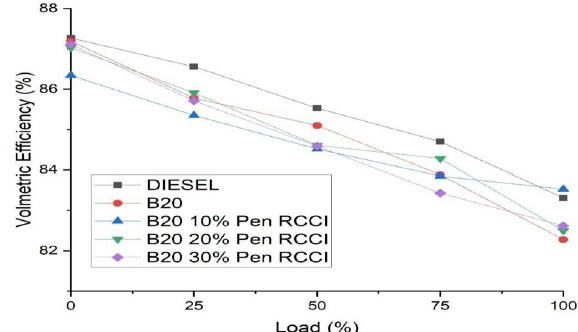
Figure 5. Volumetric efficiency versus load.